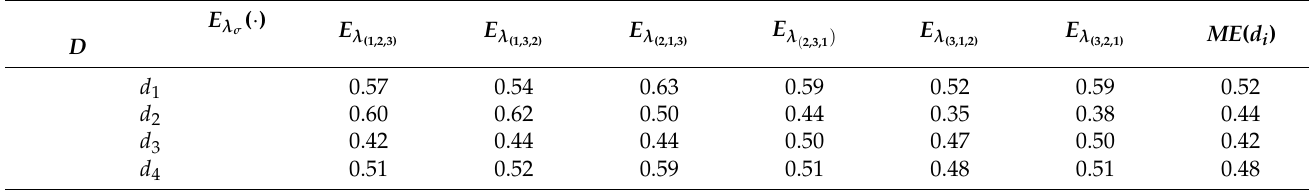
Table 3. Associated expectations and monotone expectations for the alternatives d i , i = 1, . . . ,4.